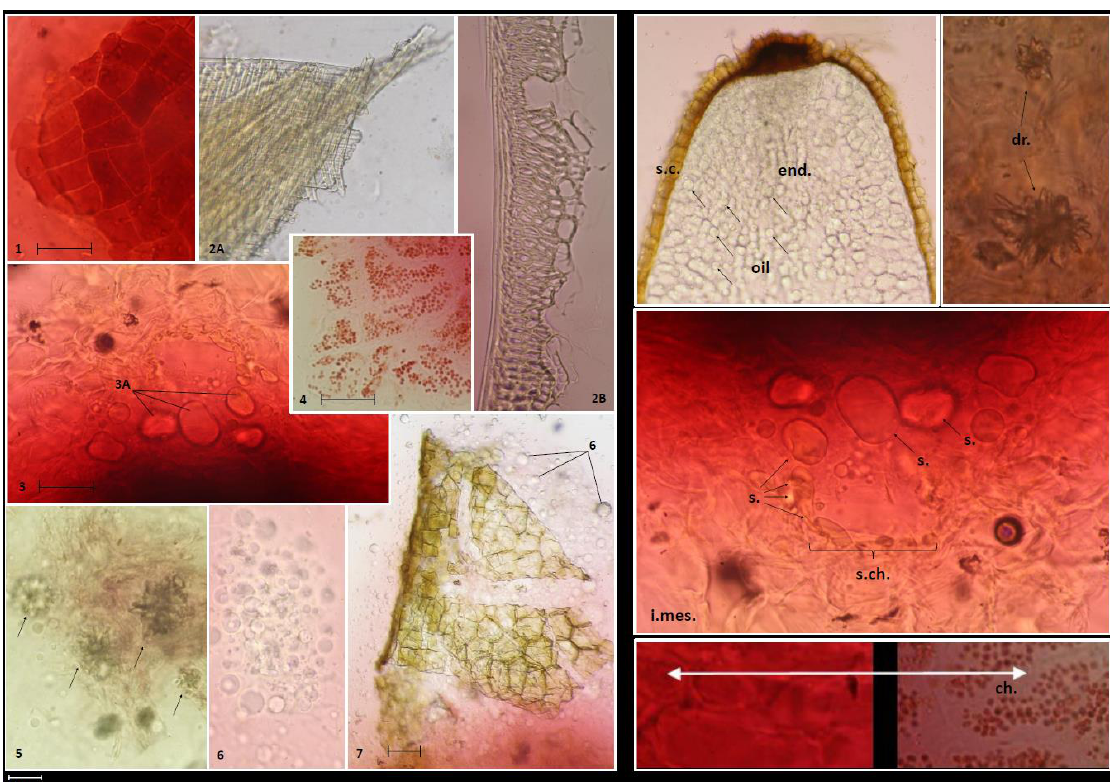
Figure 3. Diagnostic features of powdered fruits. 1 . Polygonal cells of fruit epidermis (exocarp). 2 . Inner layers of endocarp cells are represented by fibers, oriented askew to stone axis (2A—tangential section, 2B—transverse section). 3 . Secretory canal (cross-section) in mesocarp, parenchymal cells (3A—visible oil content). 4 . Outer part of the mesocarp composed of parenchymal cells containing red plastids (chromoplasts). 5 . Druses in mesocarp cells located closer to the endocarp. 6 . Drops of fatty oil from the endosperm. 7 . Seed coat built of large cells with brown contents. Diagnostic features of the fruits. s.c.—seed coat, end.—endosperm, i.mes.—inner zone of mesocarp, s.ch.—secretory canals, s.—secretion (essential oil), dr.—druses, ch.—chromoplasts.